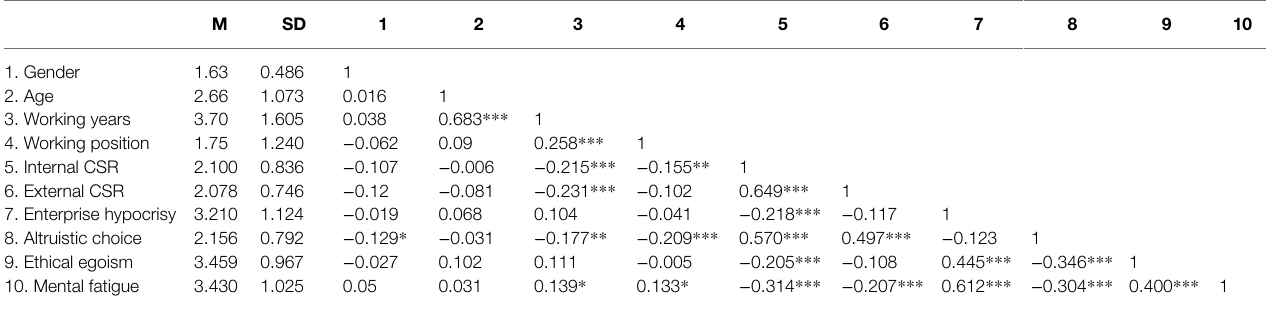
TABLE 1 | Means, standard deviations and correlation coefficient analyses of the variables. M SD